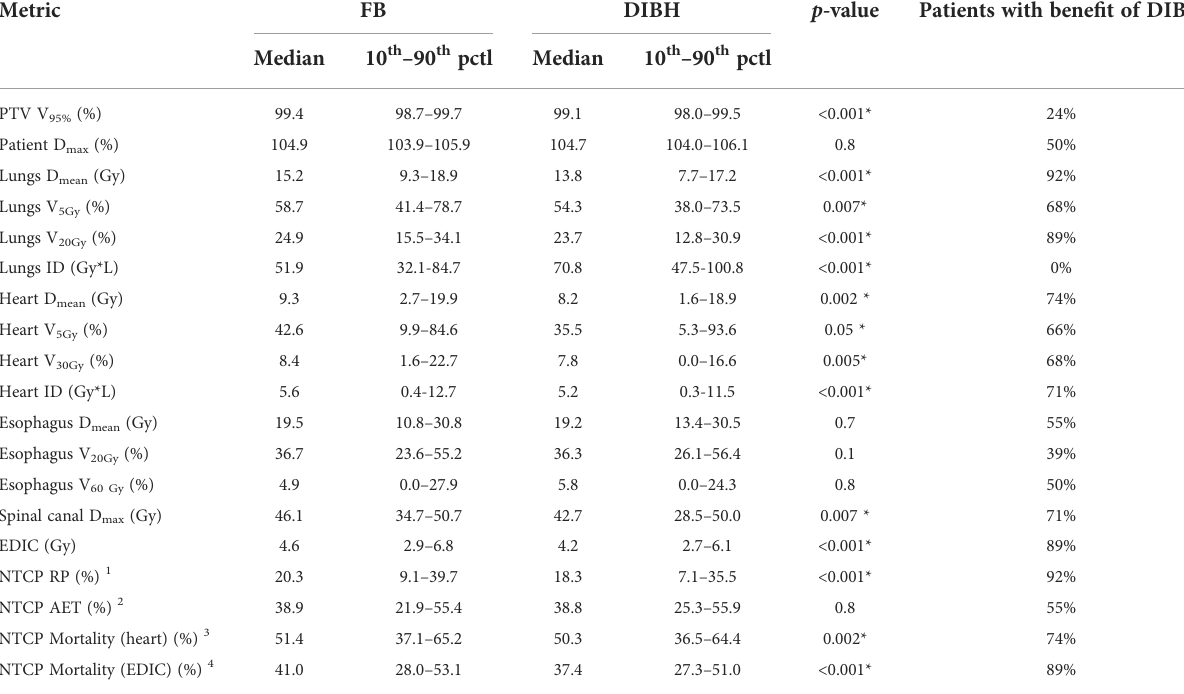
TABLE 2 Dose-volume metrics and NTCPs for FB and DIBH plans at planning.